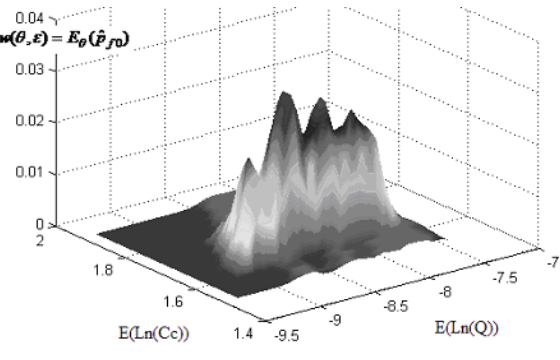
Fig 4. Numerical example for ε = 0.001